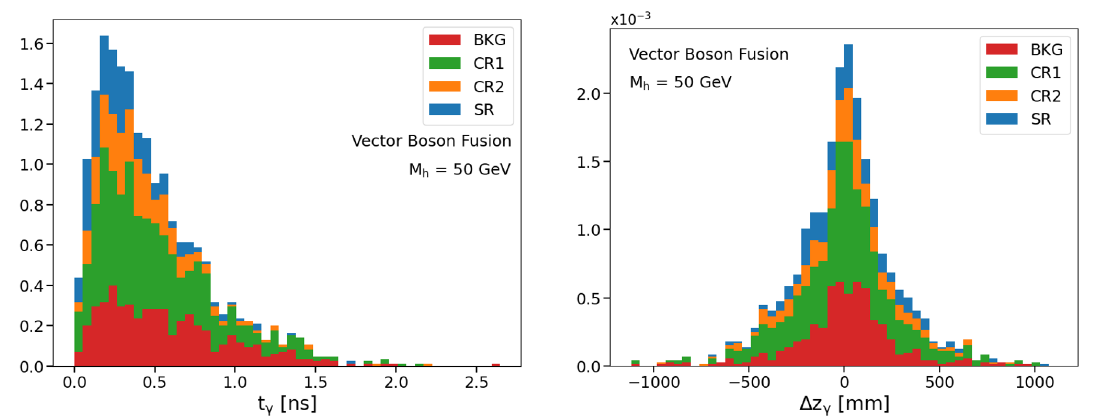
Figure 7 . Distributions of t γ (left) and ∆ z γ for the M h = 50 GeV case, considering VBF production. We show in red, green, orange and blue the generated signal events classified in the BKG, CR1, CR2 and SR regions,